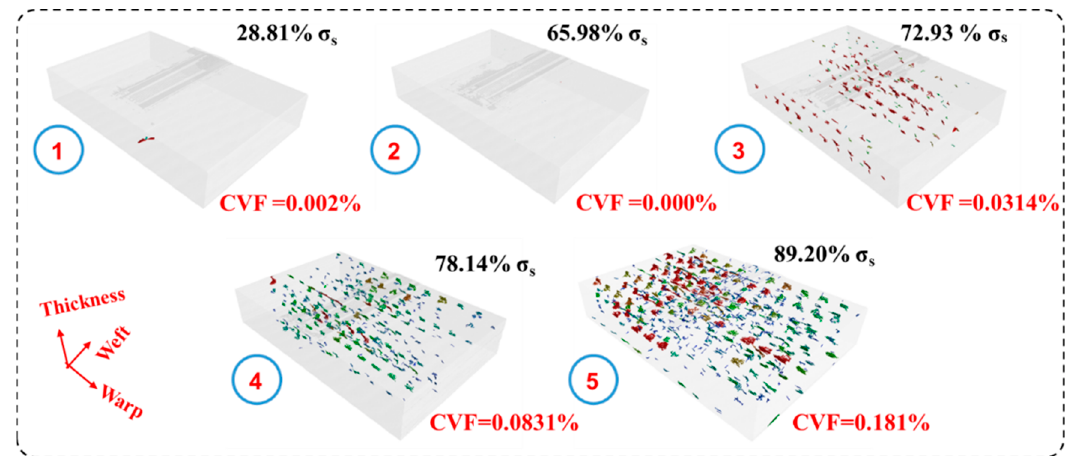
Figure 10. Micro-XCT 3D reconstruction at the five phases showing the microcracks evolution process.